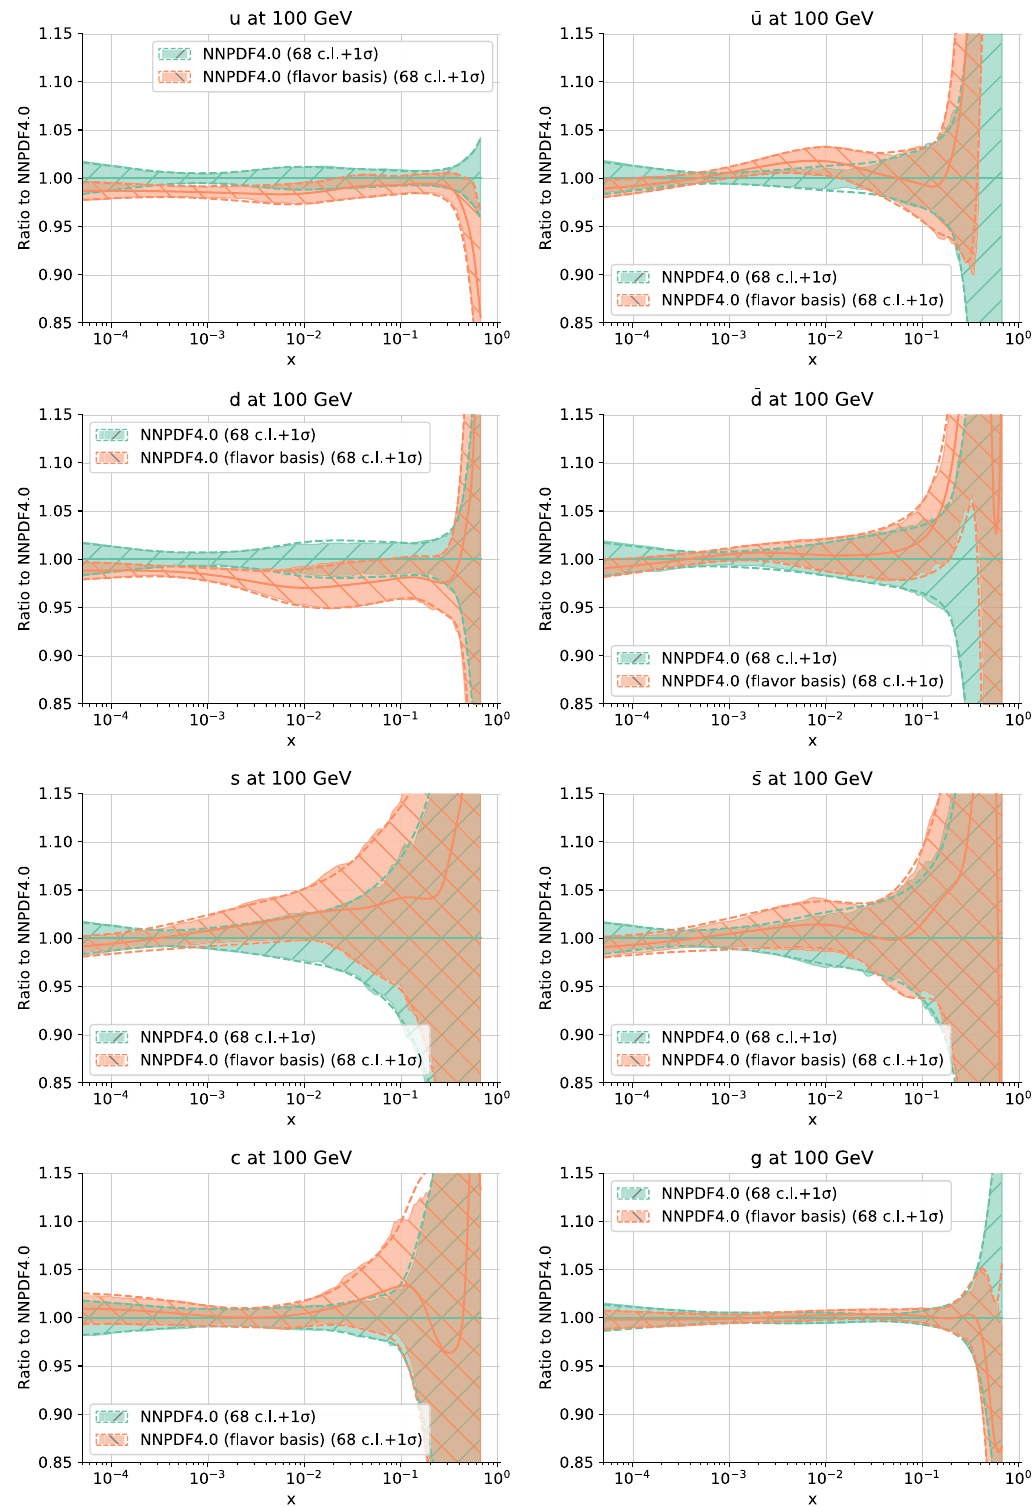
Fig. 50 Same as Fig. 33, but now comparing the baseline PDFs, parametrized in the evolution basis, to PDFs parametrized in the flavor basis and determined with the corresponding hyperparameter settings of Table